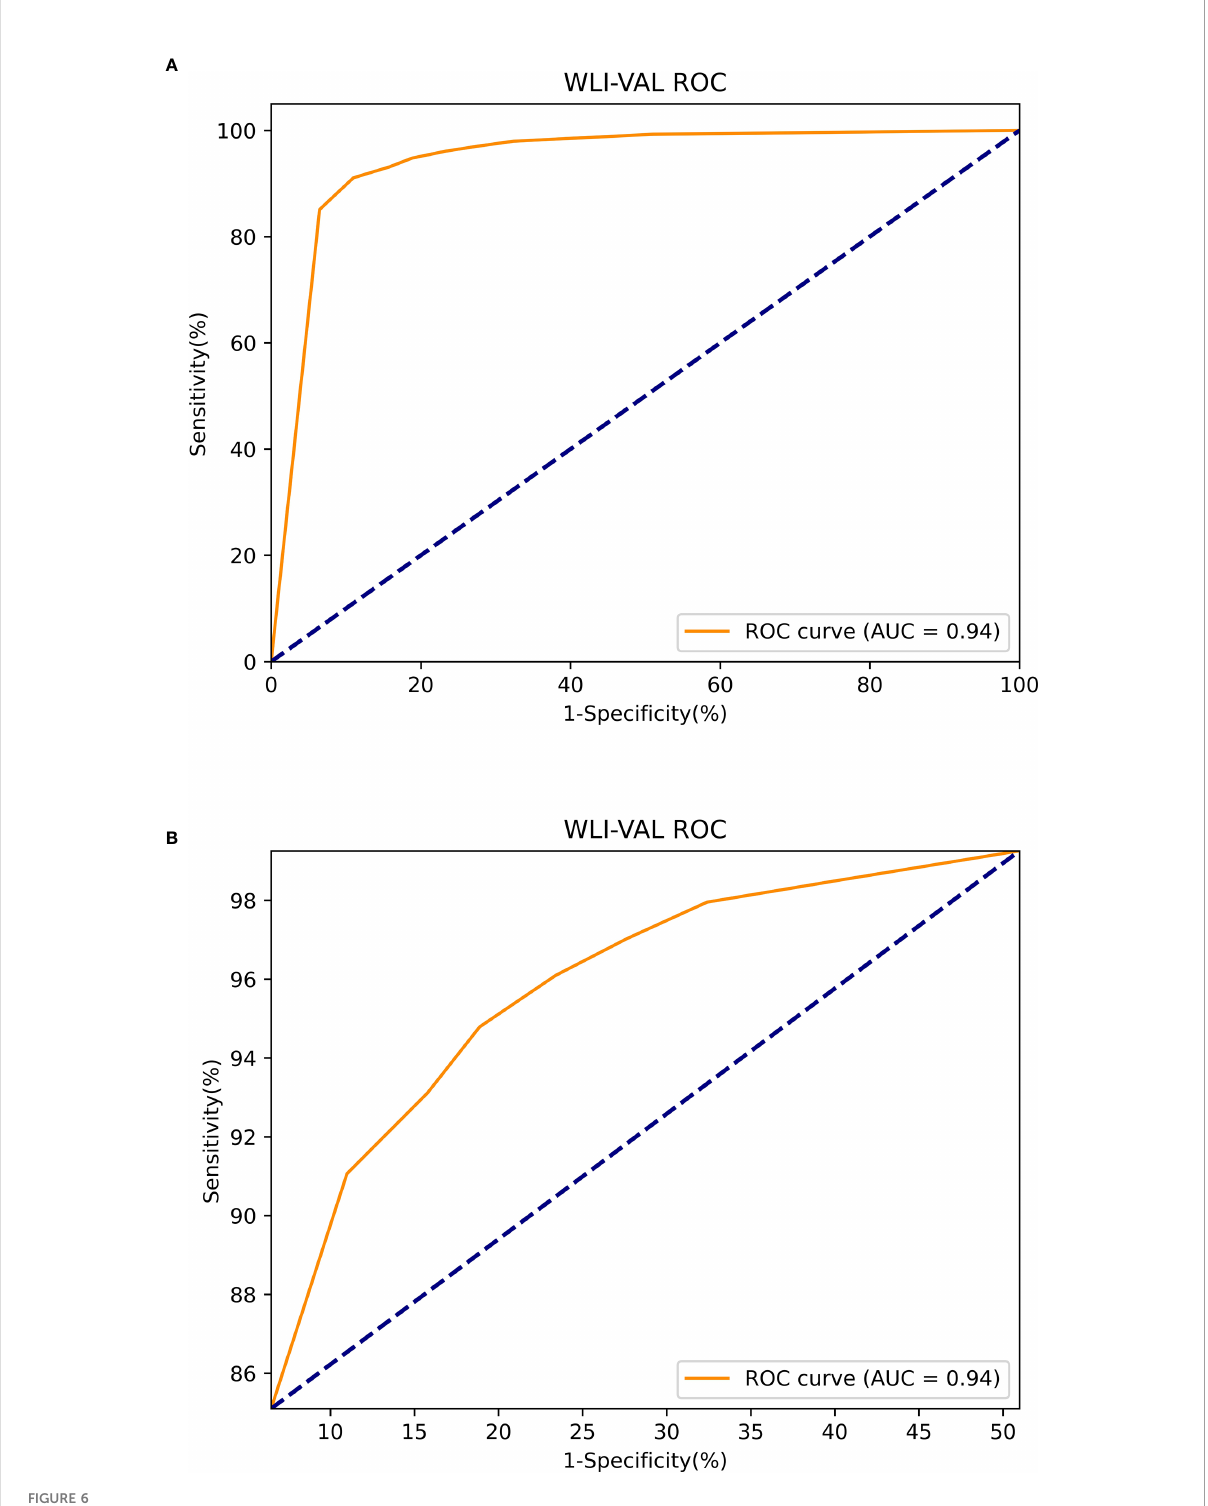
FIGURE 6 The ROC curve of the white light images test. (A) The global ROC curve of the white light images test. (B) The regional ROC curve of the white light images